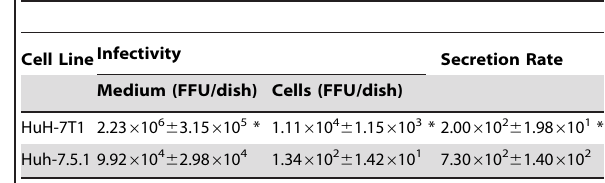
Table 1. Infectivity titers in culture medium and cells of HuH- 7T1 and Huh-7.5.1 transfected with JFH-1 RNA.